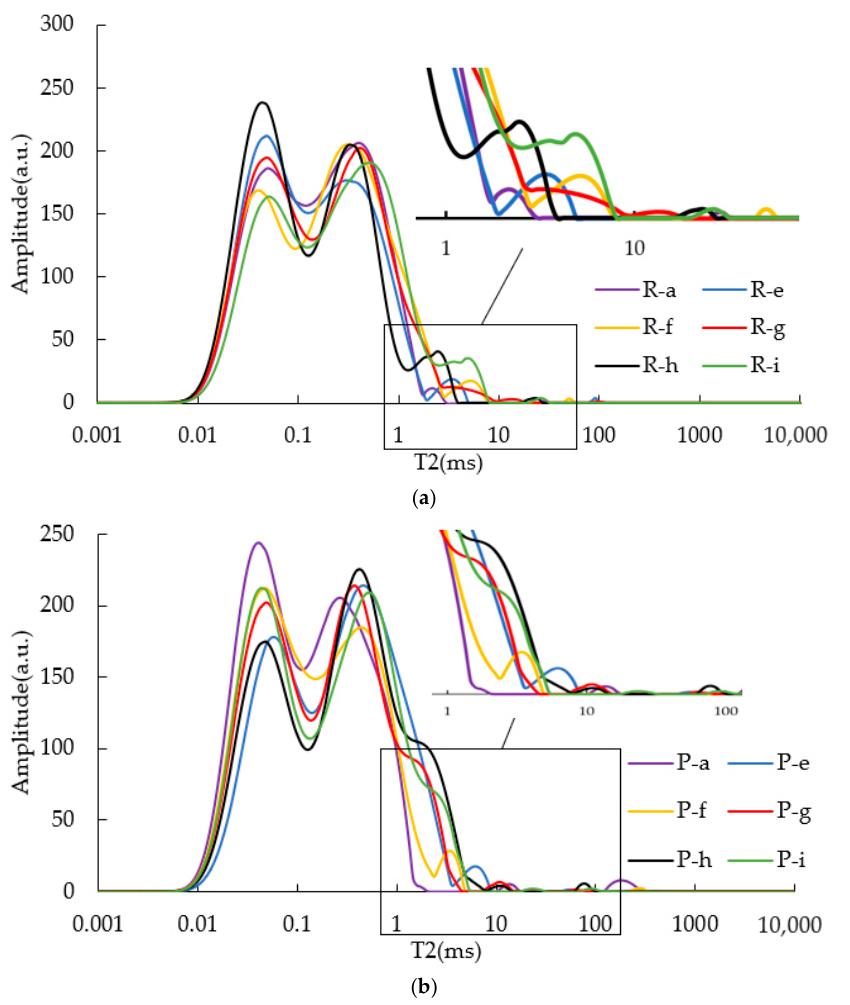
Figure 8. T2 of aged CRM asphalt binders. ( a ) T2 of RTFOT CRM asphalt binders; ( b ) T2 of PAV CRM asphalt binders.